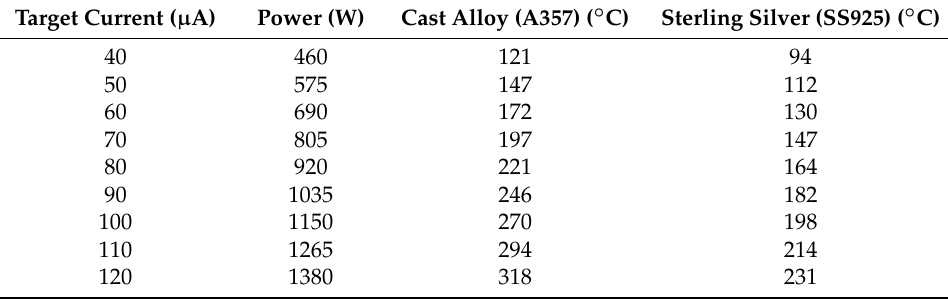
Table 1. Maximum calculated temperatures for A357 and SS925 solid target stations.